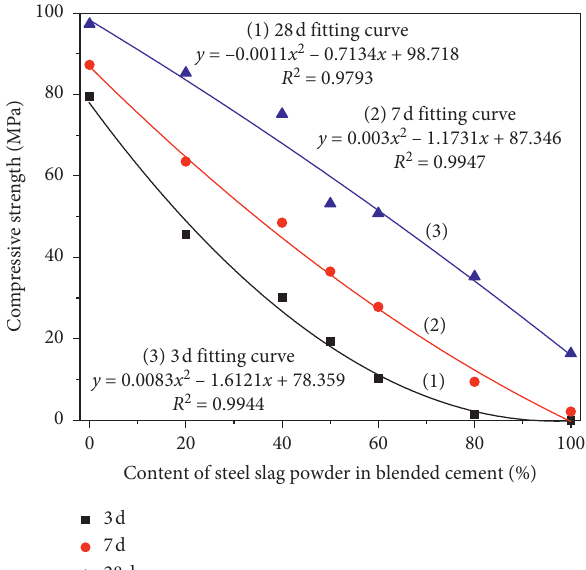
6: Strength and fitting result of blended cement containing steel slag powder.